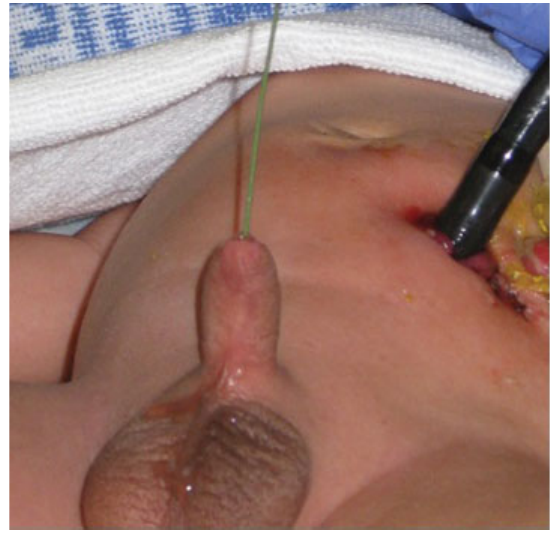
Fig. 2 Through the endoscope of 9 mm, a guidewire of 2.5 mm has been passed through the rectourethral fi